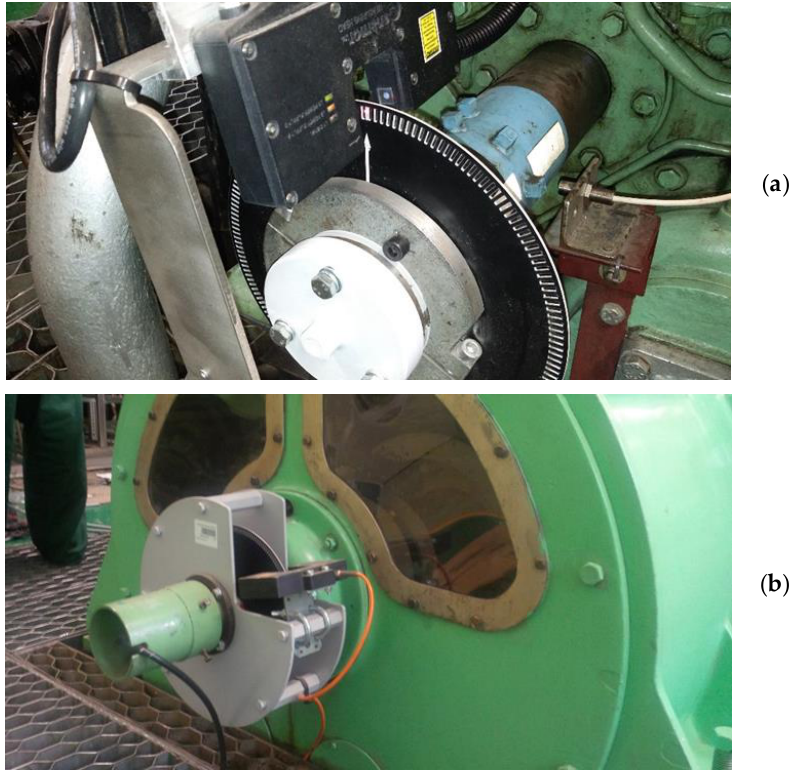
Figure 3. ETNP-10 laser heads are mounted on both free ends of the shaft and track the movement of perforated discs with 180 symmetrical slots along their perimeter (( a )—view from the engine side, ( b )—view from the generator side)).